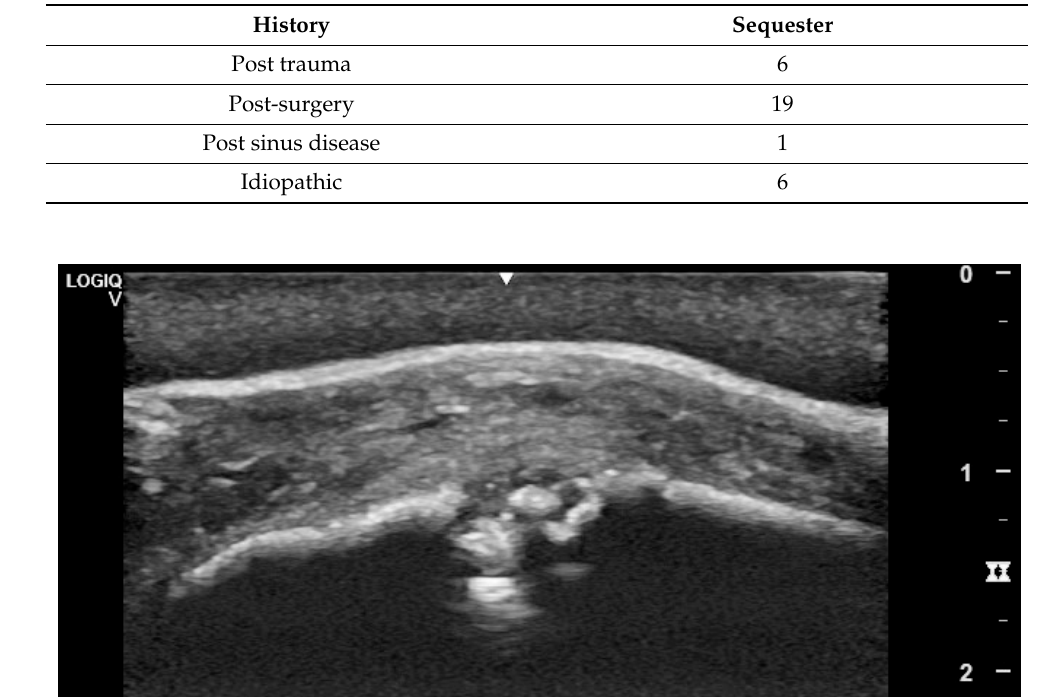
Figure 6. X-ray of a horse with mild to moderate, but painful suture exostosis with sequester formation. Table 6. Number of cases reported with presence of bone sequestra in 105 equine cases of suture exostosis divided according to history of appearance.